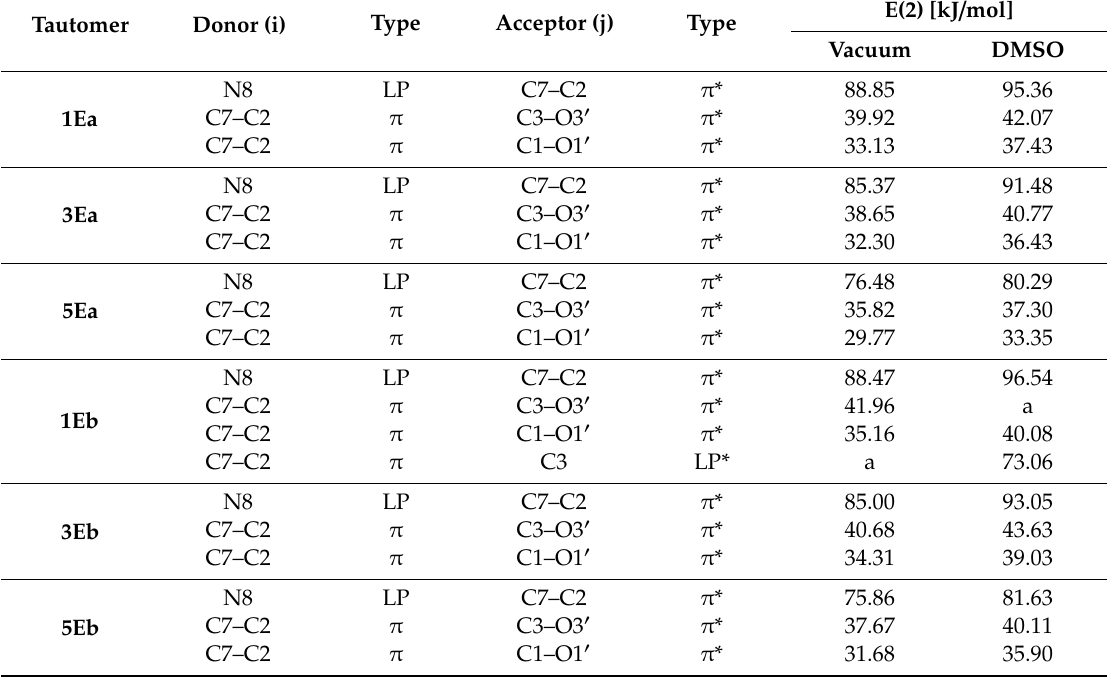
Table 4. Calculated stabilization energies (E(2)) for selected donor (i) –acceptor (j) interactions in the studied tautomers.